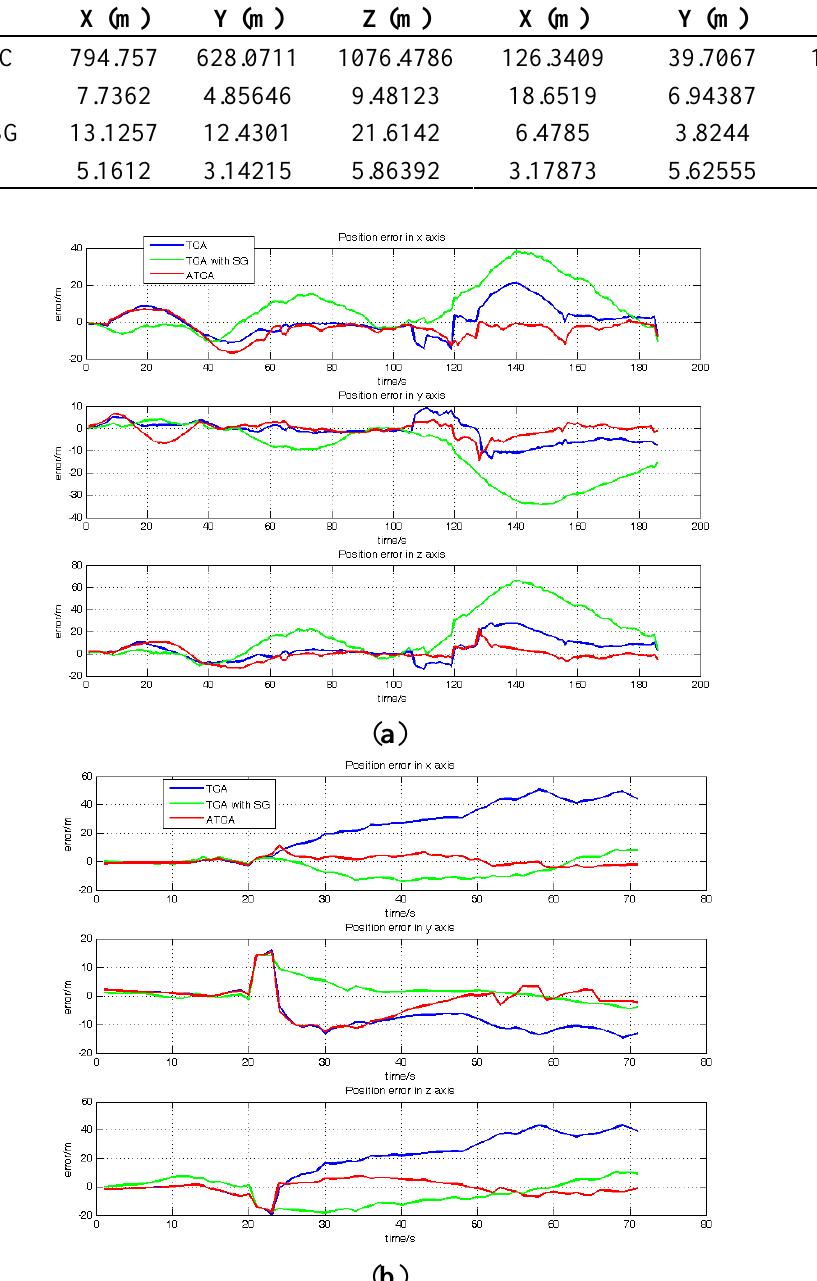
Figure 15. Position error comparisons: ( a ) position errors of TCA, TCA with SG and ATCA in the ECEF frame during the periods of 345 s and 530 s; ( b ) position errors of TCA, TCA with SG and ATCA in the ECEF frame during the periods of 1450 s and 1500